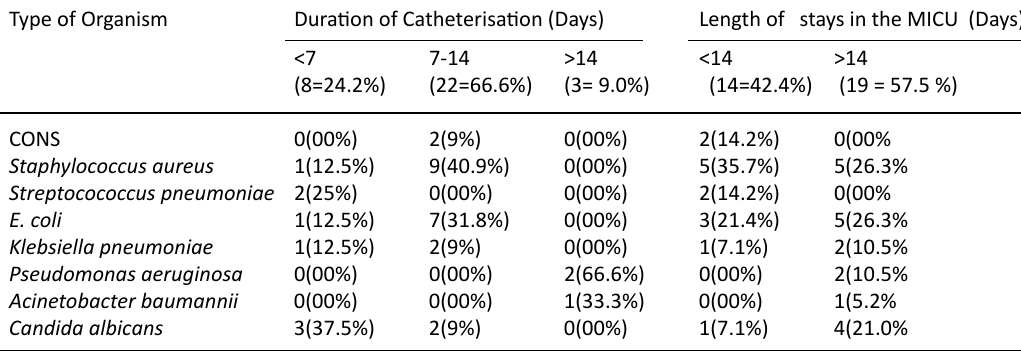
Table 5. Spectrum of Pathogens according to Duration of Catheterization & Length of ICU stays. Type of Organism